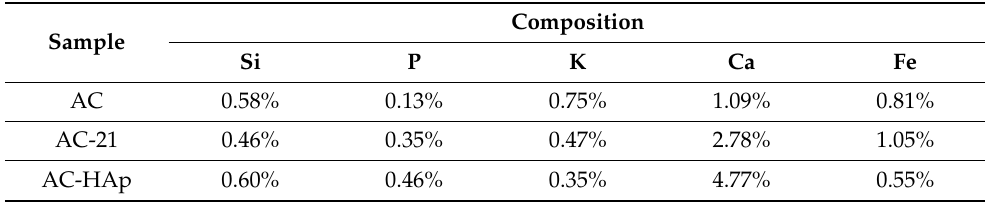
Table 1. Compositions of carbon-based